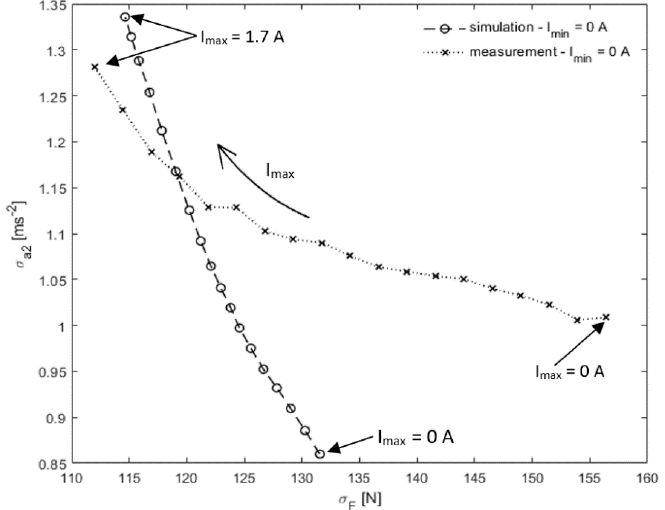
Figure 7. Groundhook setting — activated state setting (changing activated state current — I max ).